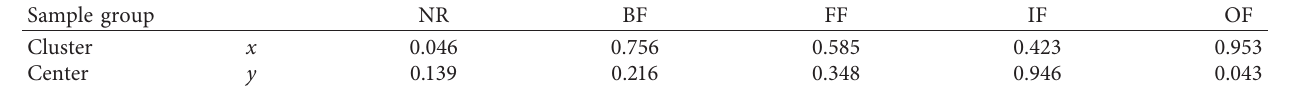
Table 7: The cluster centers for five types of signals.